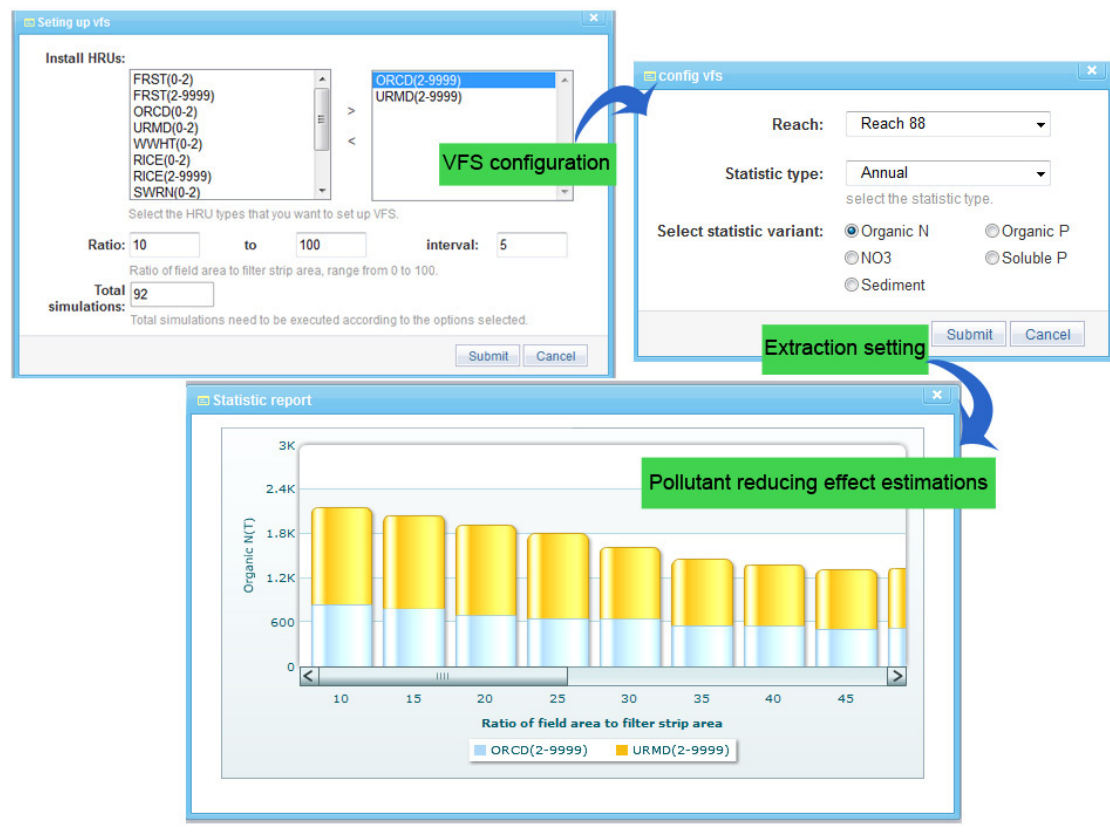
Figure 4. Interfaces of the vegetation filter strip